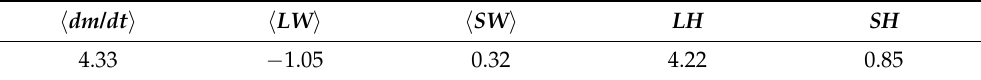
Figure 3. Temporal evolution of ( a ) column-integrated MSE (black; 10 11 J m − 2 ) and ( b ) column-integrated kinetic energy (black; 10 5 J m − 2 ) integrated from surface to 18 km within a radius of 150 km. For comparison, the TC MWS (red; knots) and MSLP (blue; hPa) are also shown. Table 1. Contributions to the total derivative of the column-integrated MSE (cid:104) dm / dt (cid:105) from hour 24 to hour 48 by different terms, long wave radiation (cid:104) LW (cid:105) , short wave radiation (cid:104) SW (cid:105) , latent heat flux LH , and sensible heat flux SH averaged between hour 24 and hour 48 (unit: 10 3 W m − 2 ).